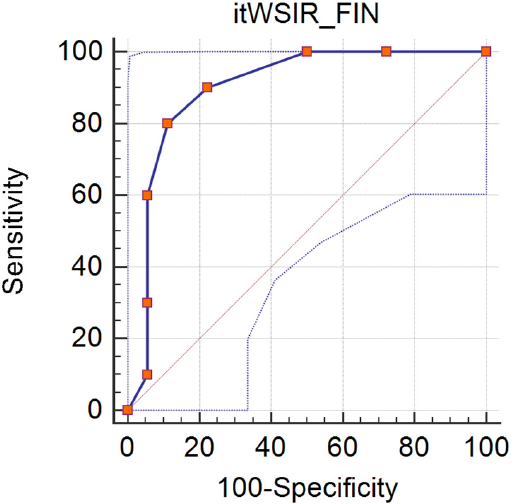
Figure 9. ROC curve for Italian WSIR finiteness screening task (distinction between morphosyntactic risk, n = 10, and no risk, n = 18), AUC = 0.900.